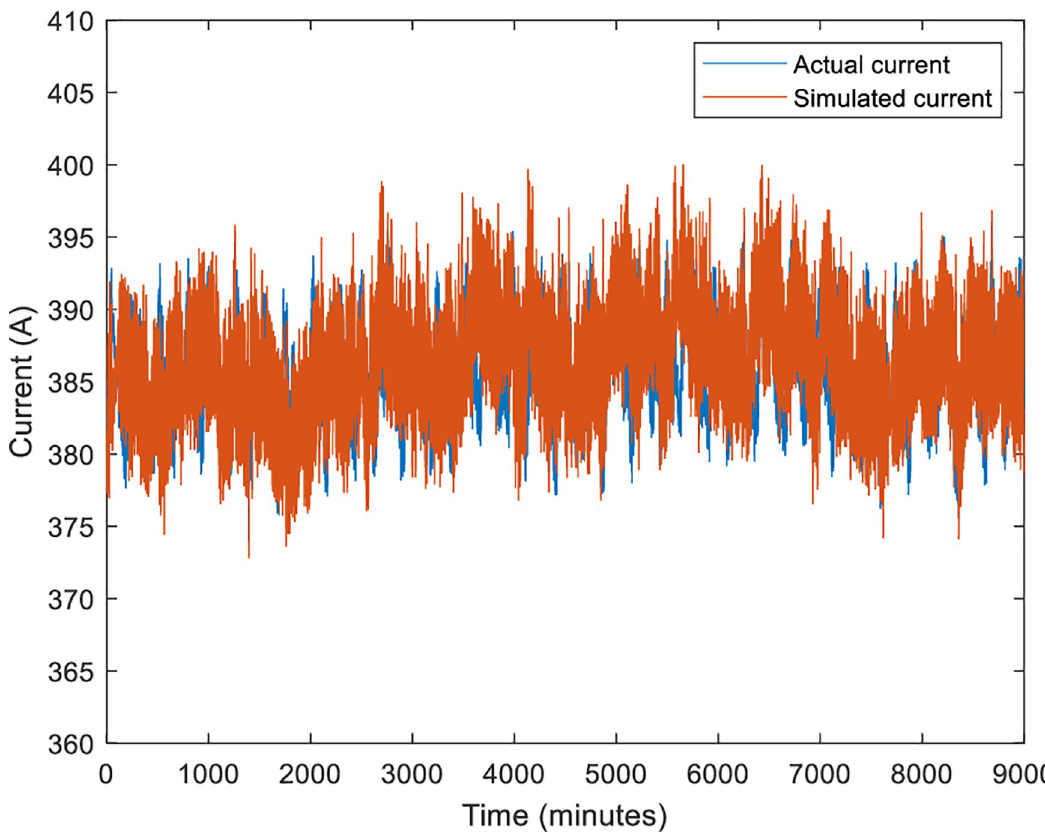
Fig 7. Comparison between actual and simulated